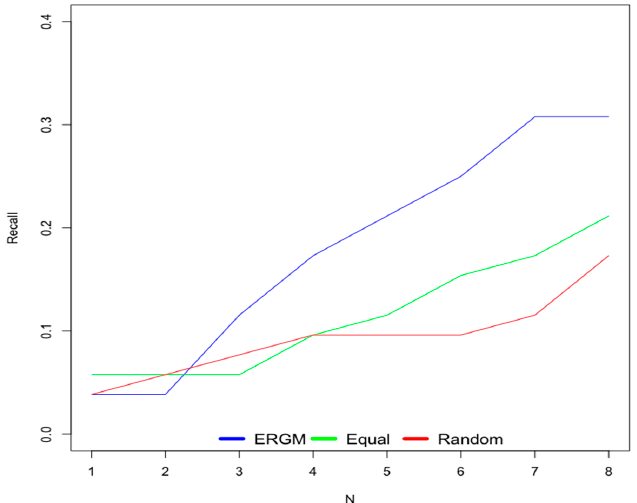
Figure 6. Recall for old users.